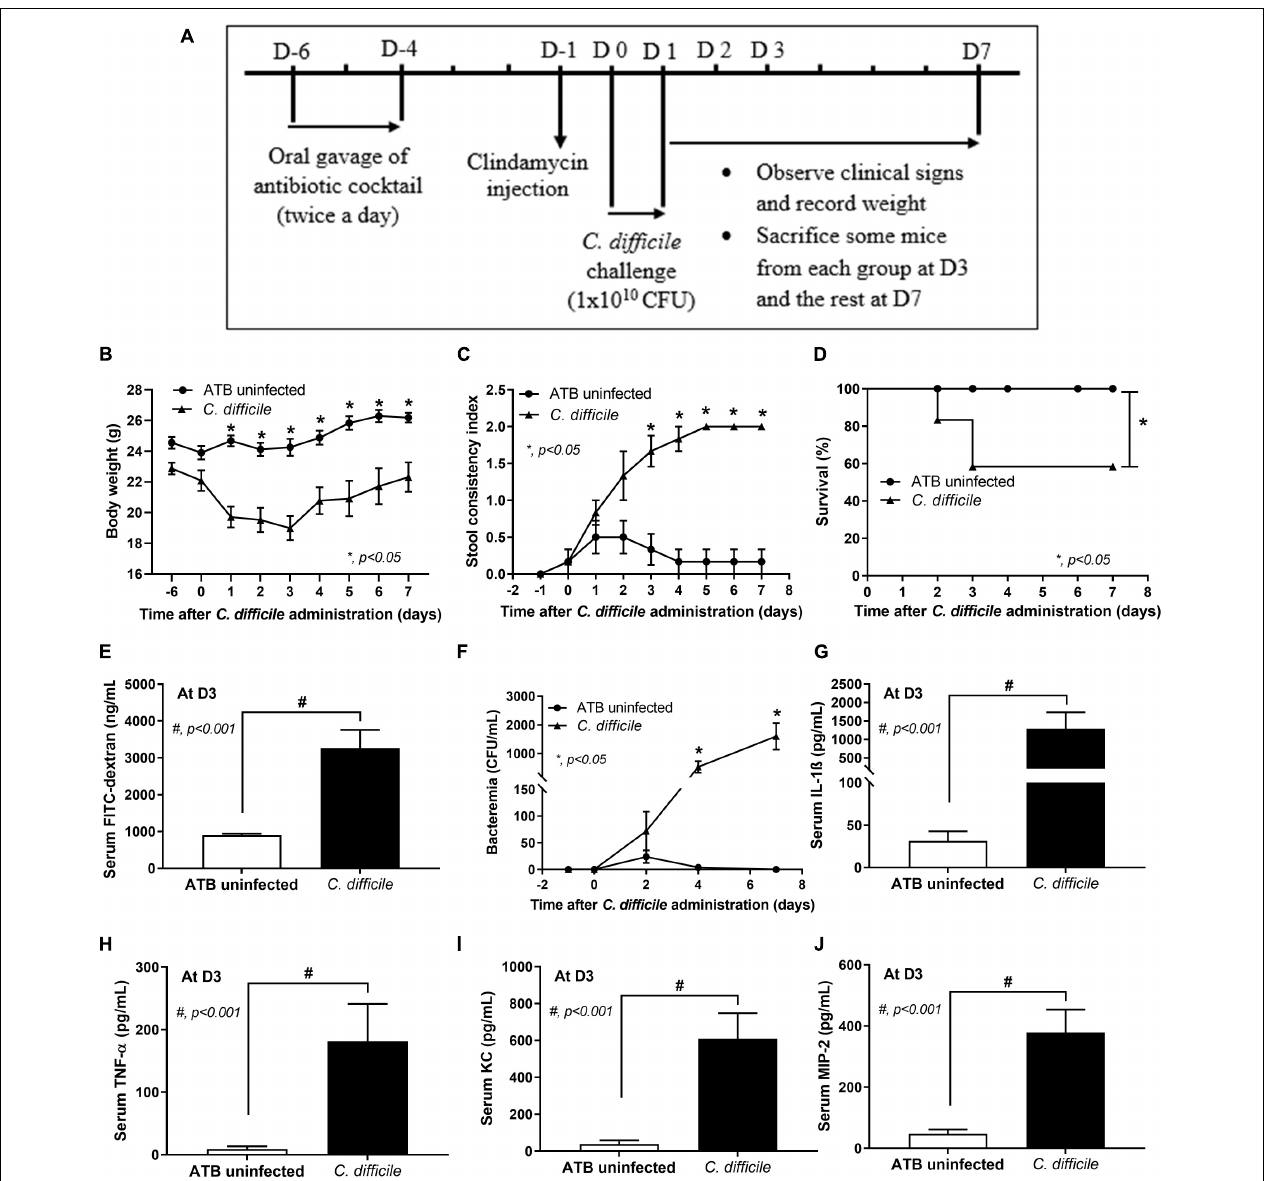
FIGURE 1 | Murine model of C. difficile infection. Mice in the antibiotic-administered uninfected group (ATB uninfected group; n = 12) and C. difficile -infected group ( C. difficile group; n = 24) were used in the experiment as in the schematic presentation (A) . The severity of C. difficile infection in mice is manifested by weight loss (n = number of mice/group or survivors) (B) ; stool consistency index (n = number of mice/group or survivors) (C) ; survival rate (D) ; bacteremia (n = number of mice/group or survivors) (E) ; gut leakage by serum FITC-dextran assay monitored at day 3 ( n = 8) (F) ; and levels of serum pro-inflammatory cytokines IL-1 β (G) , TNF- α (H) , KC (I) , and MIP-2 (J) at day 3 ( n = 8). * p < 0.05; # p < 0.001. FITC, fluorescein isothiocyanate; IL, interleukin; TNF, tumor necrosis factor; KC, keratinocyte chemoattractant; MIP-2, macrophage inflammatory protein